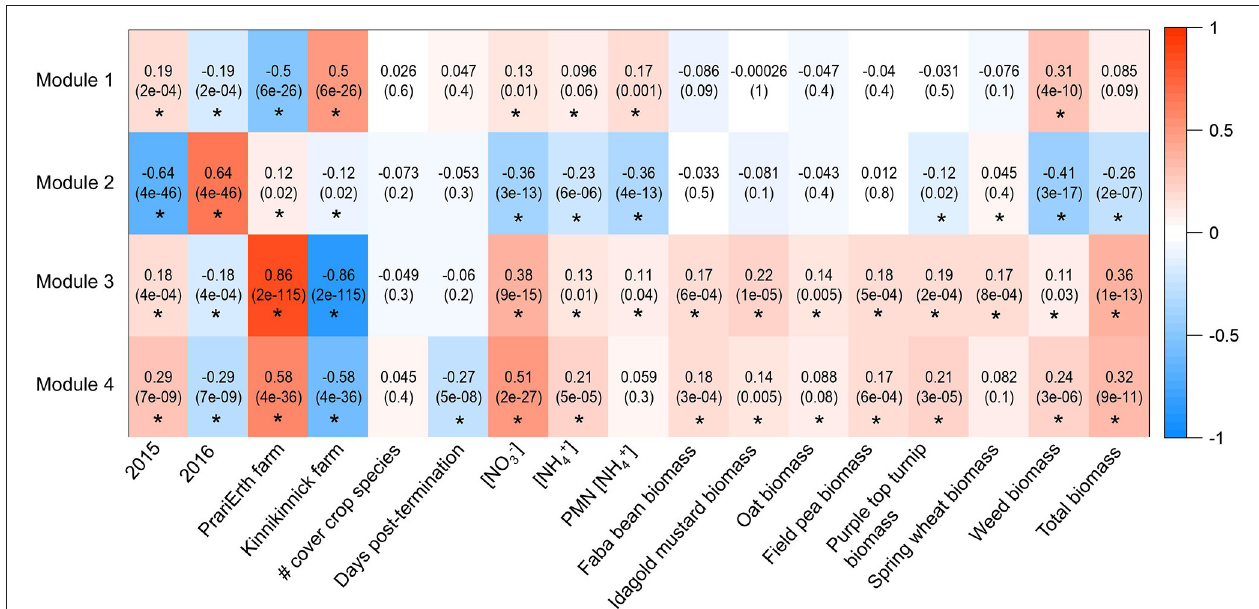
FIGURE 3 | Heatmap generated for 16S WGCNA analysis. Values are correlations and p -values are in parentheses. Asterisks indicate significant correlations at the level of p < 0.05.